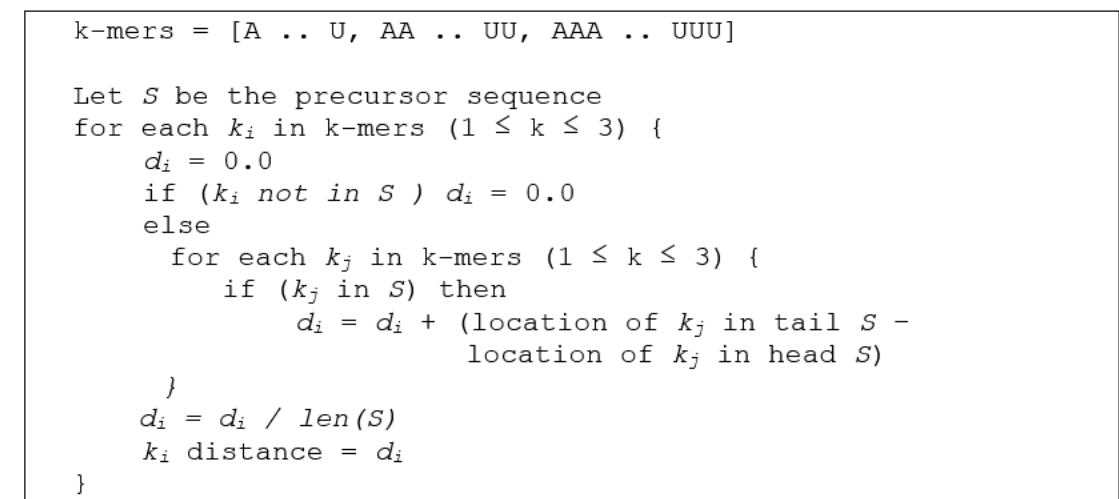
Figure 1. The description of the algorithm calculating the inter k-mer distance features from the pre-miRNA sequence.